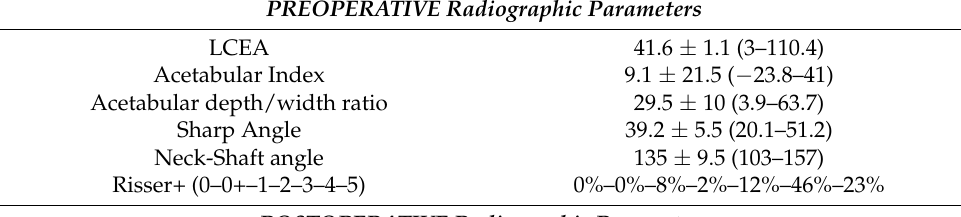
Table 4. Preoperative and postoperative radiographic parameters. All results are expressed as crude numbers for dichotomous variables and as mean ± Standard Deviation for continue variables. LCEA: Lateral center-edge angle. * Varus inclination is expressed as negative value, positive value for